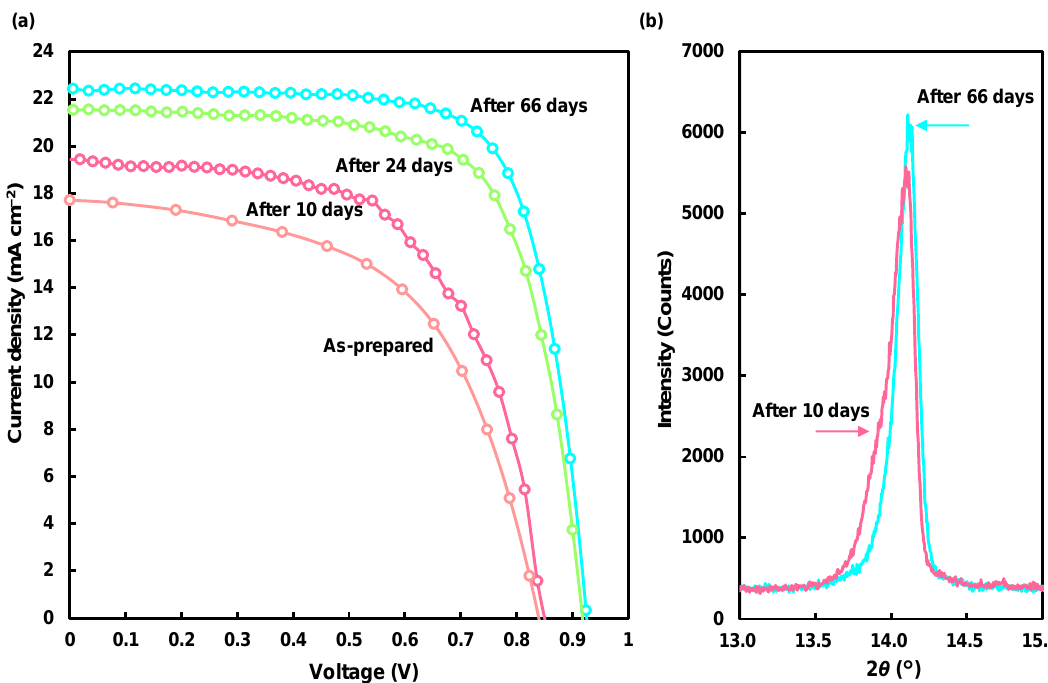
Table 4. Changes of crystallographic data of perovskite films.